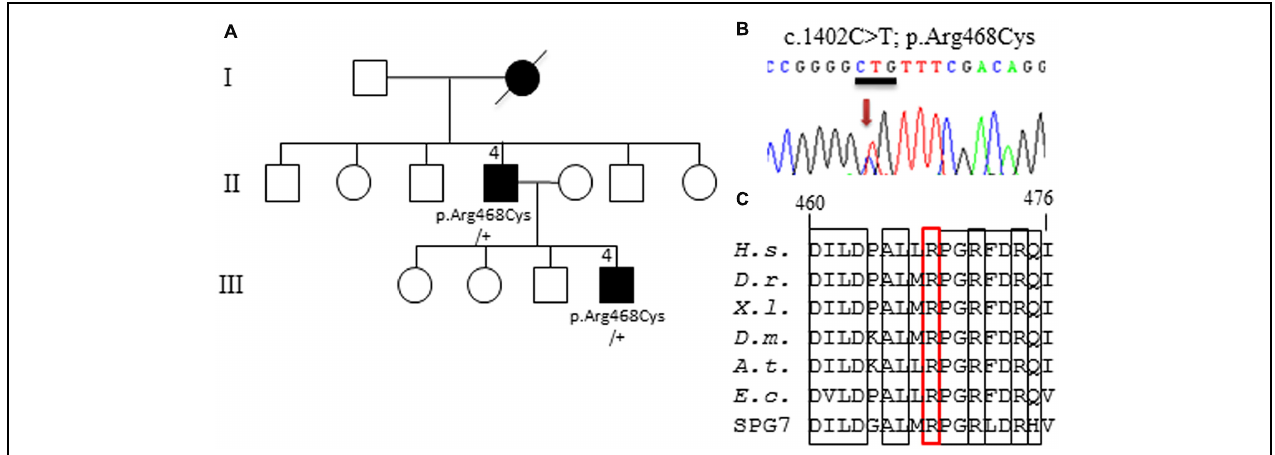
FIGURE 1 | Identification of AFG3L2 mutation. (A) Pedigree showing the family with the affected members in black, and the segregation of the p.Arg468Cys amino-acid change in the two affected patients, knowing that DNA sample was not available for the other family members. (B) Electrophoregram presenting the AFG3L2 c.1402C > T heterozygous mutation. (C) Alignment of AFG3L2 orthologs (amino-acids 460 to 476) showing the evolutionary conserved positions around the Arginine 468, which is squared in red in the triple arginine motif (bold rectangles). ( H.s. Homo sapiens; D.r. Danio rerio; X.l. Xenopus laevis; D.m. Drosophila melanogaster; A.t. Arabidopsis thaliana; E.c. Escherichia coli FtsH protein ; SPG7: human paralog of AFG3L2).